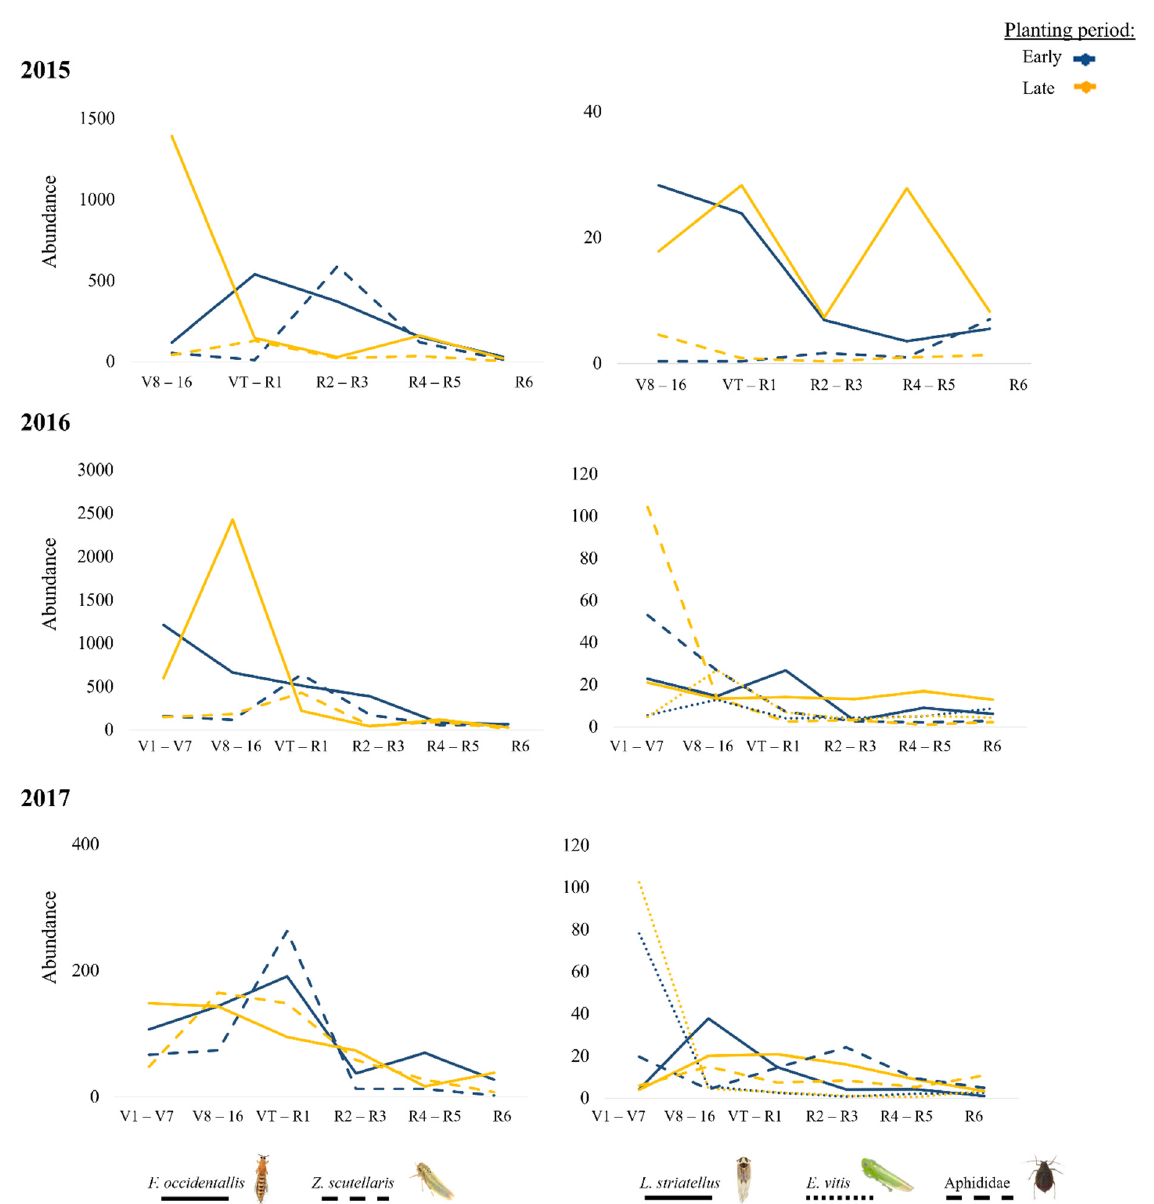
Figure 3. Herbivore abundance according to the maize phenology each year in each planting period (blue line = late; yellow line = early). The species that had significant differences ( p < 0.05) in the analyses are shown. (More details in Supplementary